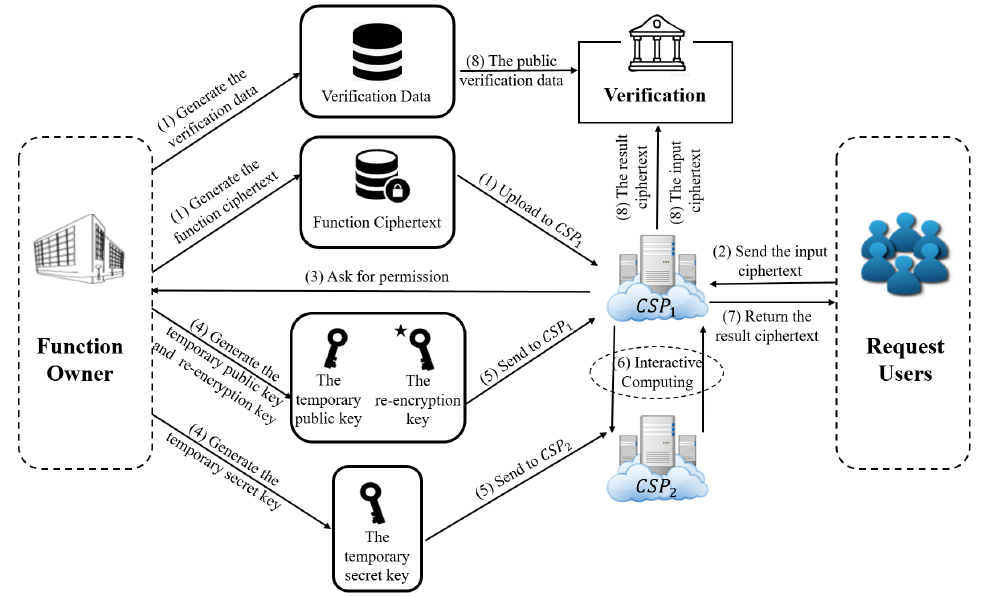
Figure 2. The publicly verifiable outsourcing computation model with